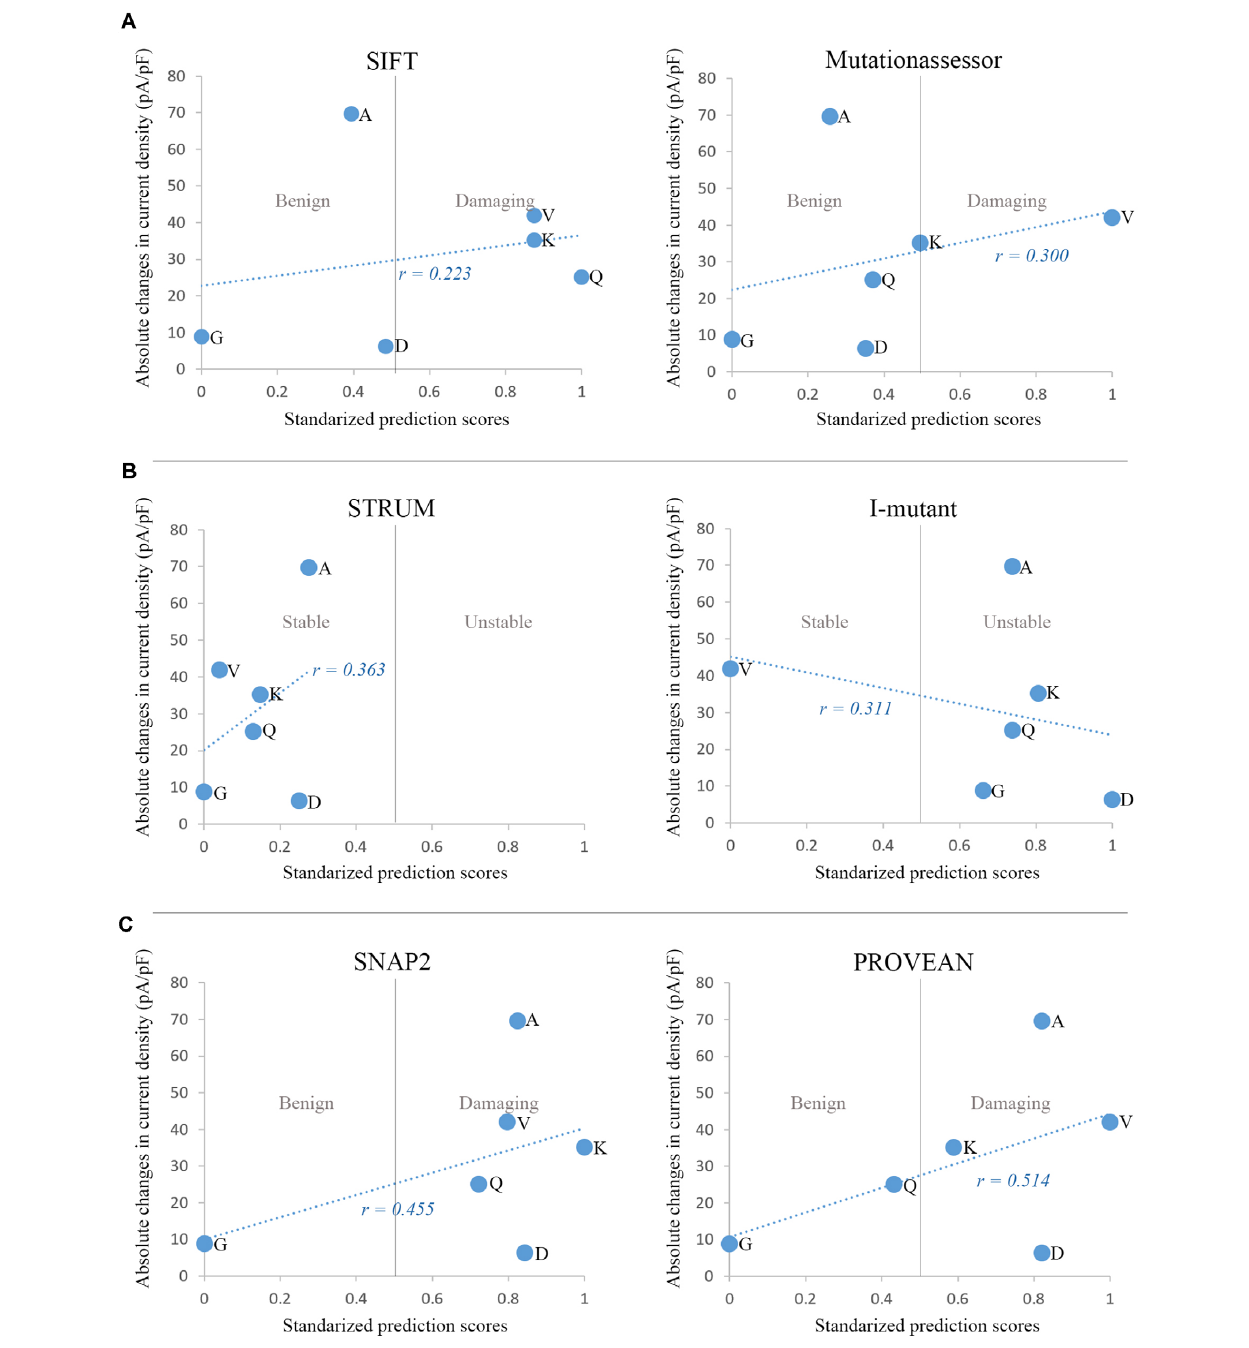
FIGURE 6 | Correlations between in silico prediction scores and functional changes in current density. (A) Sequence and evolutionary conservation-based methods: SIFT and Mutationassessor. (B) Prediction of protein stability changes by Strum and I-mutant suite. (C) Machine-learning methods combining comprehensive features: SNAP2 and PROVEAN. For comparison, prediction scores of the six variants from different tools were normalized to the Polyphen-2 scoring scheme, with a range from 0 to 1 and a threshold at 0.5. The minimal score with benign prediction was set as 0, and the maximal score with damaging prediction was set as 1. Scores with benign prediction were scaled to a range from 0 to 0.5, while scores of damaging variants were scaled to a range from 0.5 to